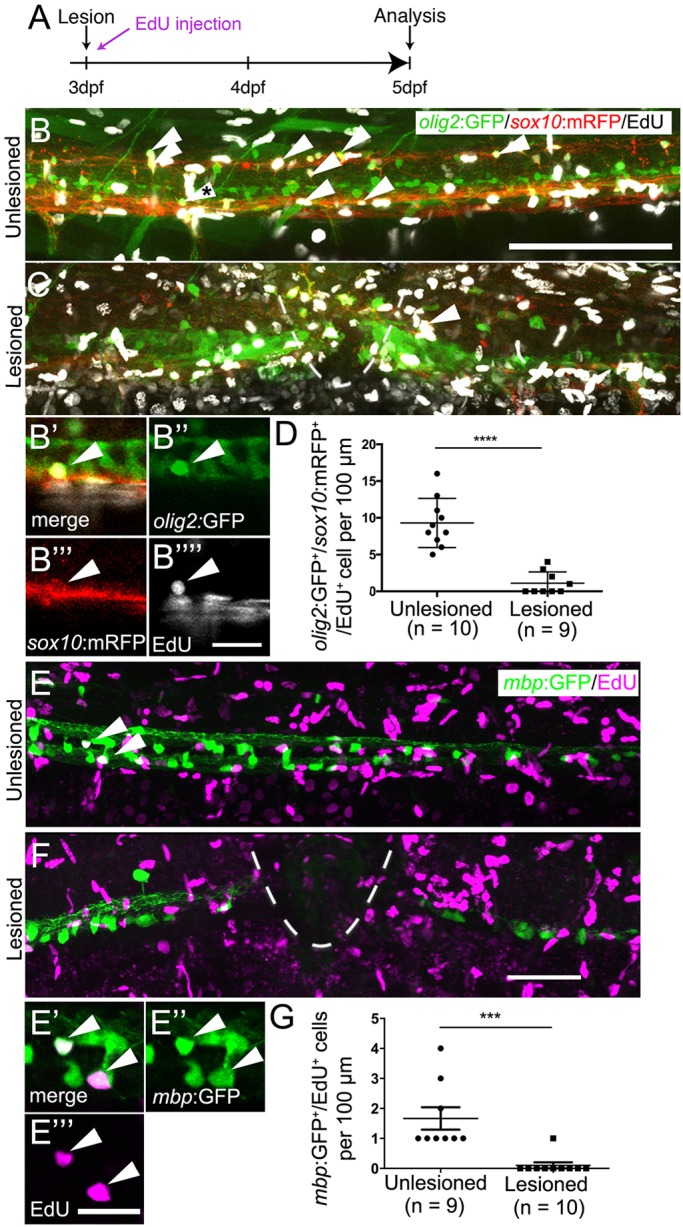
Oligodendrocyte generation is reduced after a spinal lesion. (A) Time line of the experiment. (B,C) Newly generated oligodendrocytes and their precursors, triple labelled by olig2:GFP, sox10:mRFP and EdU (arrowheads), are reduced in number after lesion. (B′-B″″) A triple-labelled cell (indicated with asterisk in B) in a single optical section at higher magnification. (D) The number of triple-labelled cells is reduced (Student's t-test, ****P<0.0001). (E) mbp:GFP+ oligodendrocytes incorporate EdU (indicated by arrowheads) in unlesioned larvae. (E′-E‴) Two double-labelled neurons indicated in E at higher magnification in a single optical section. (F) Fewer double-labelled cells are observed after a lesion. (G) The number of new oligodendrocytes is significantly reduced after a lesion (Mann–Whitney U-test; ***P=0.0005). Lateral views are shown; rostral is left, dorsal is up. The lesion site is indicated by a dashed line. Values are means±s.e.m. Scale bars: 100 µm in B for B,C; 20 µm in B″″ for B′-B″″; 50 µm in F for E,F; 20 µm in E‴.